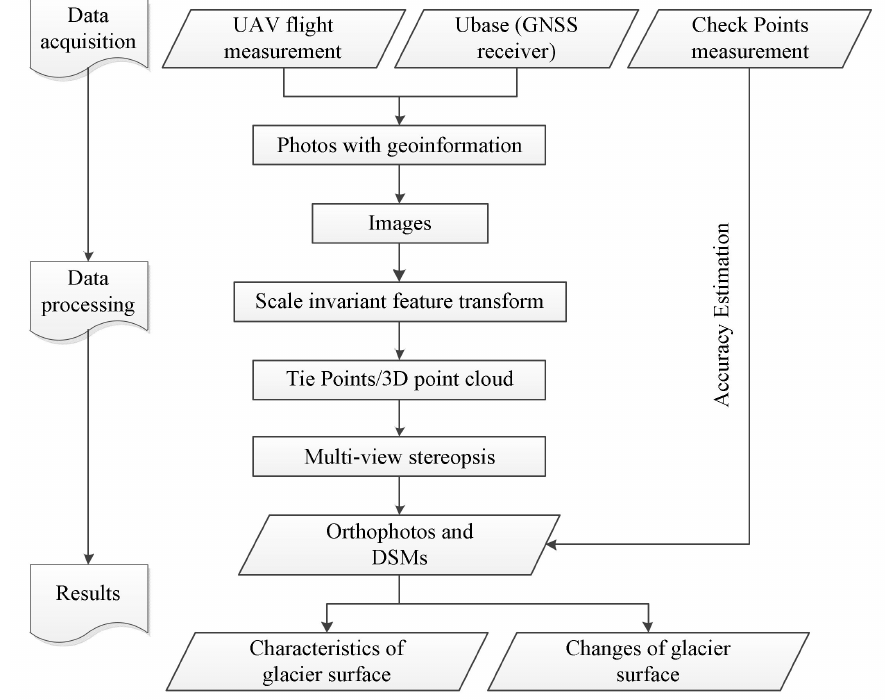
Figure 3. Workflow used for the assessment of glacier surface